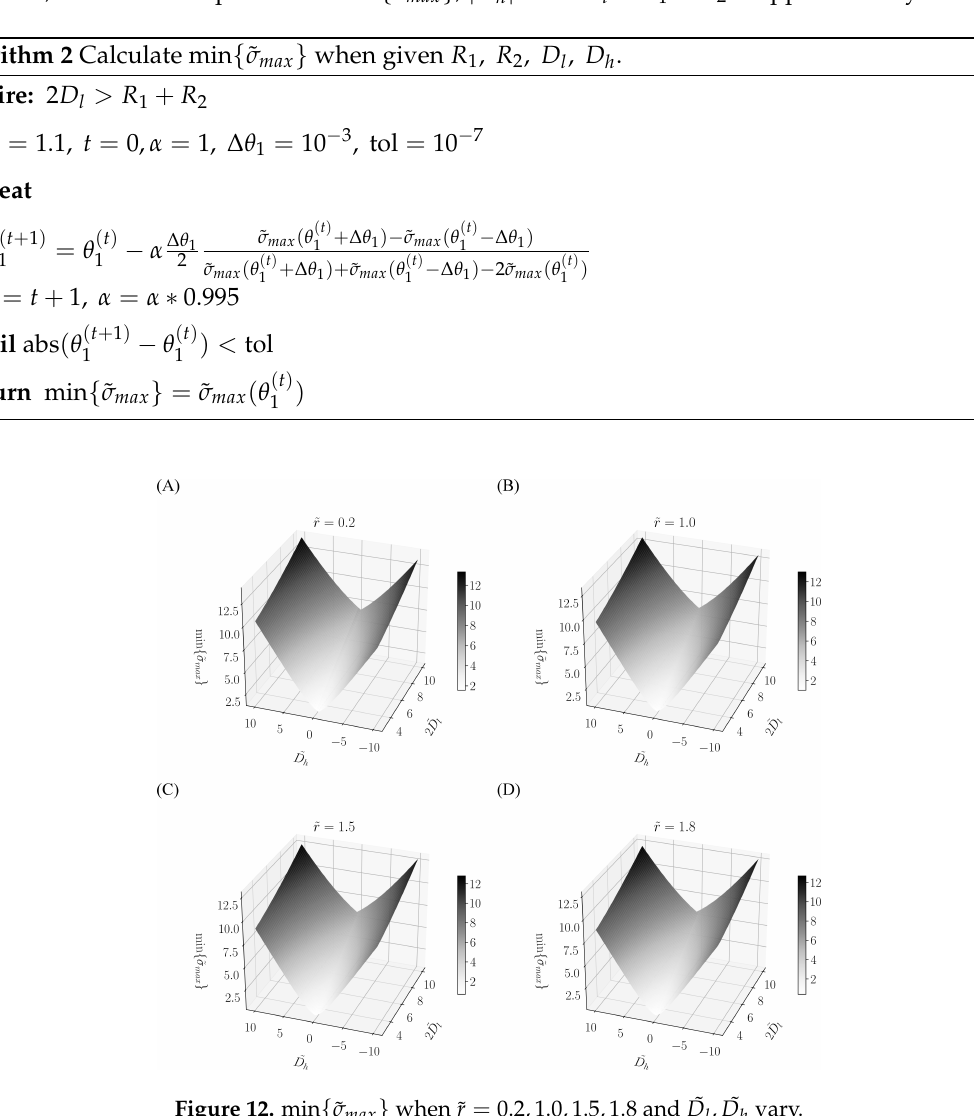
Figure 12. min { ˜ σ max } when ˜ r = 0.2,1.0,1.5,1.8 and ˜ D l , ˜ D h